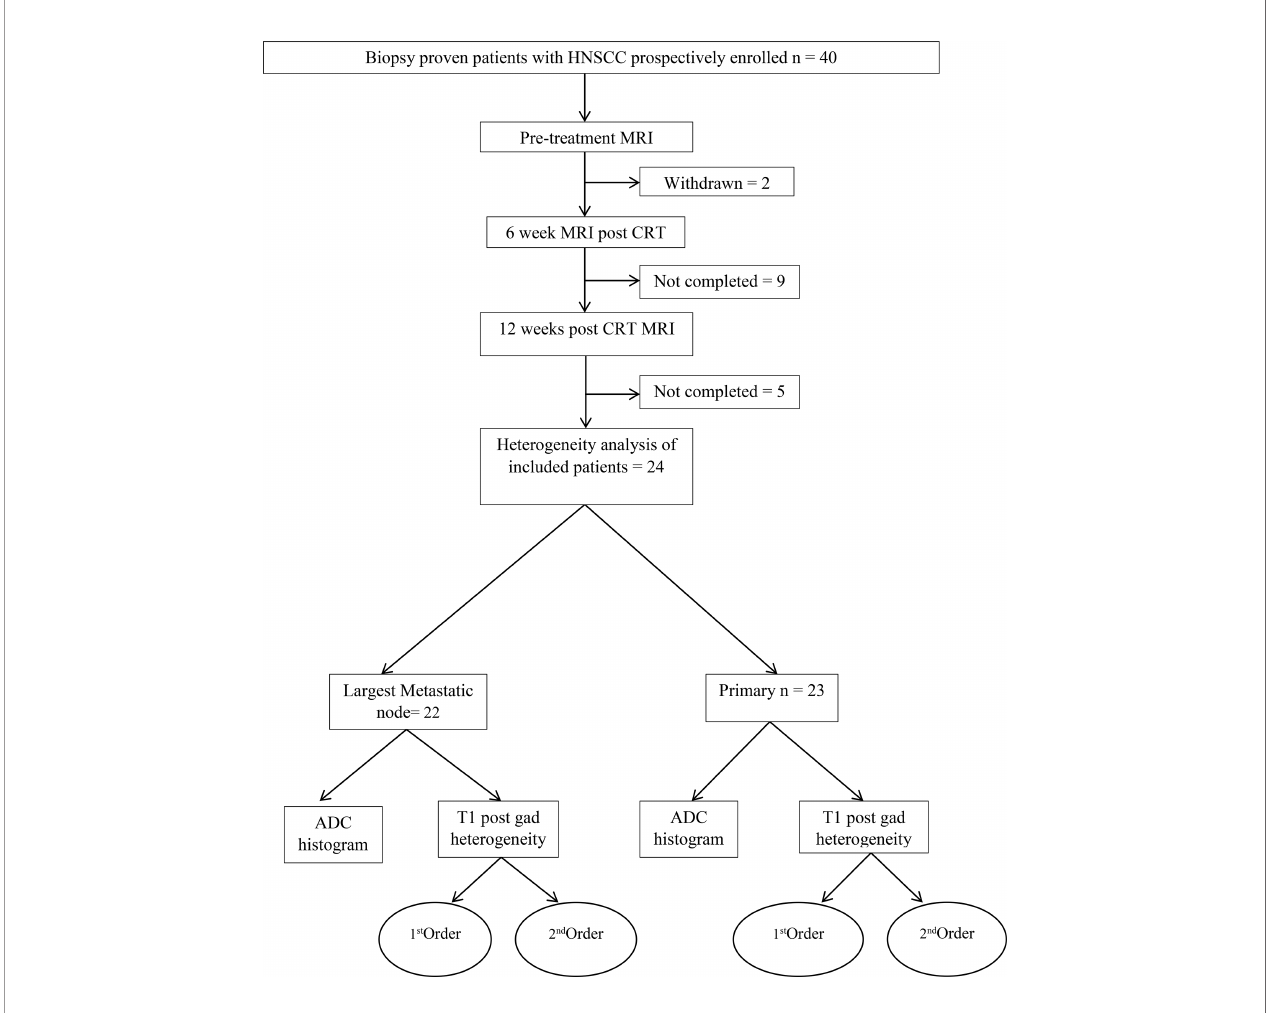
FIGURE 2 | Patient fl